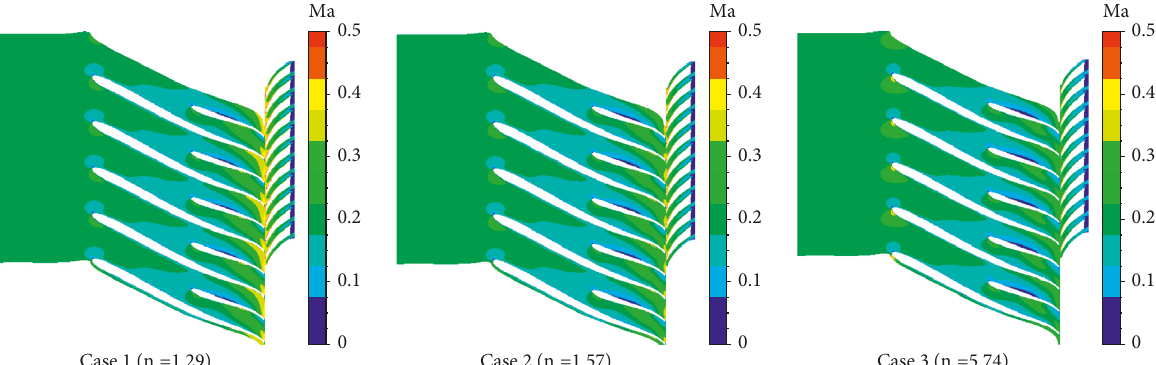
Figure 19: Mach number distribution of test cases (at 15% span).